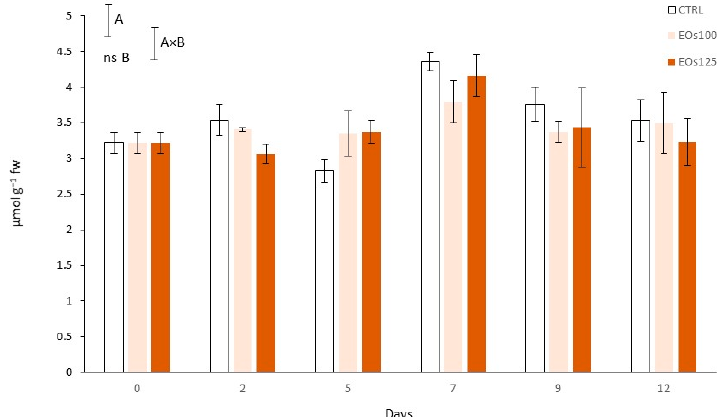
Figure 6. Total antioxidant capacity of sliced mushroom during cold storage (4 °C) under modified atmosphere packaging supplemented with vapour essential oils (100 and 125 µ L L − 1 EOs) (mean ± standard deviation). Least significant differences are represented as bars, with A and B letters for the treatment and storage time factors, respectively. ns, not significant.